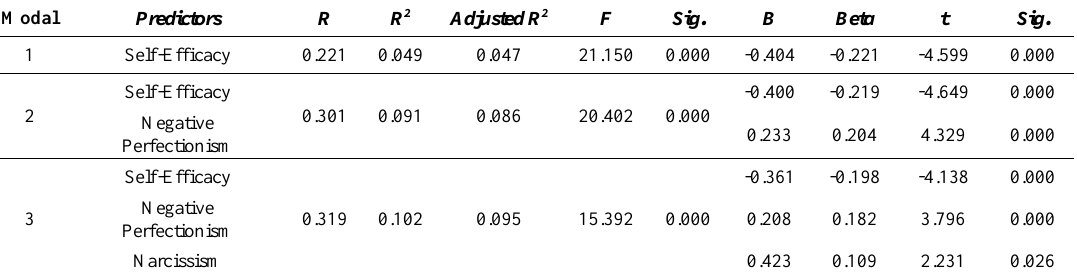
Table 2. Summary of Regression Analysis